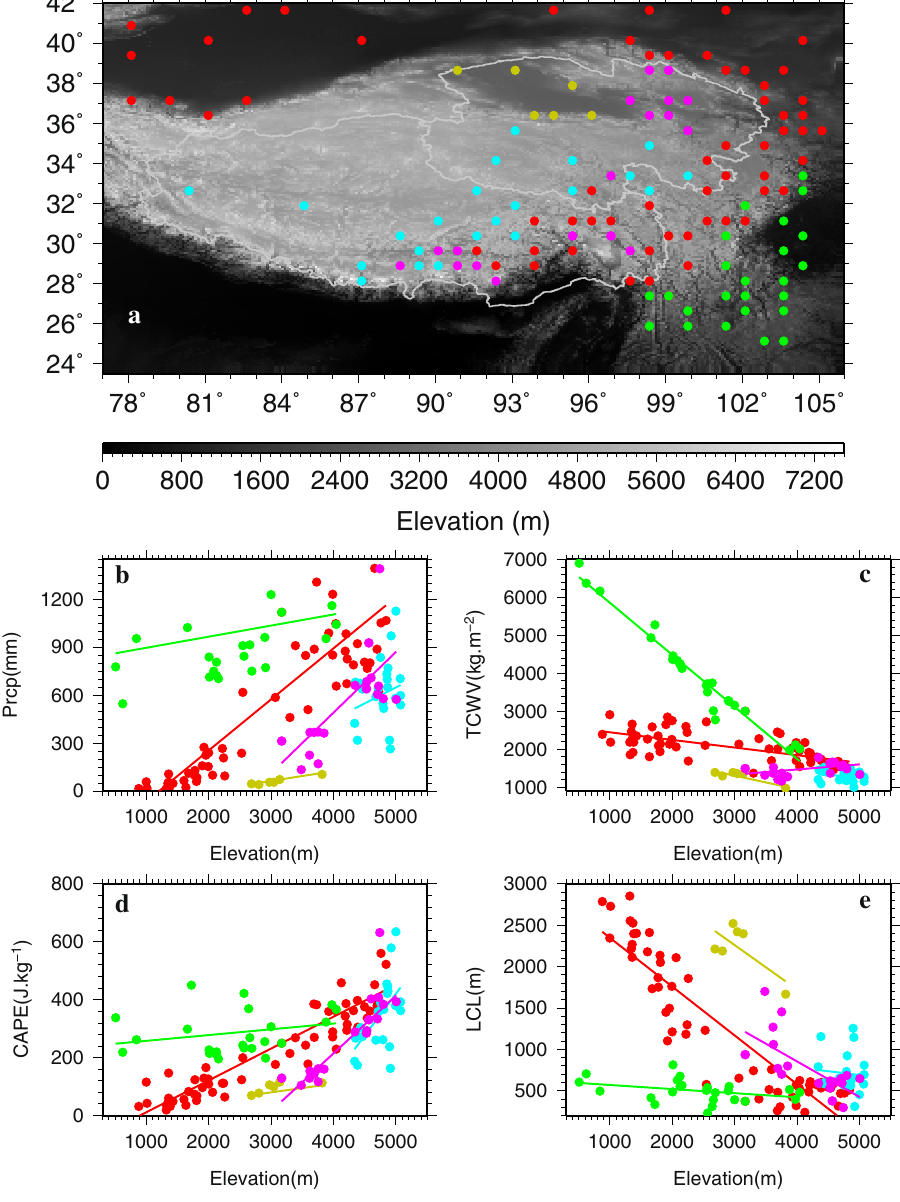
Figure 4. Locations of the ERA-Interim cells whose wet season precipitation is correlated statistically significantly at 90% confidence level with that of the corresponding stations ( a ). Vertical distributions of wet season precipitation ( b ), total column water vapor (TCWV) ( c ), convective available potential energy (CAPE) ( d ), and lifting condensation level (LCL) ( e ) with ERA-Interim elevation for the ERA-Interim cells that are separated into the same color-coded 5 groups as for the observations. This figure was plotted using the Generic Mapping Tools (GMT) V4.5.0